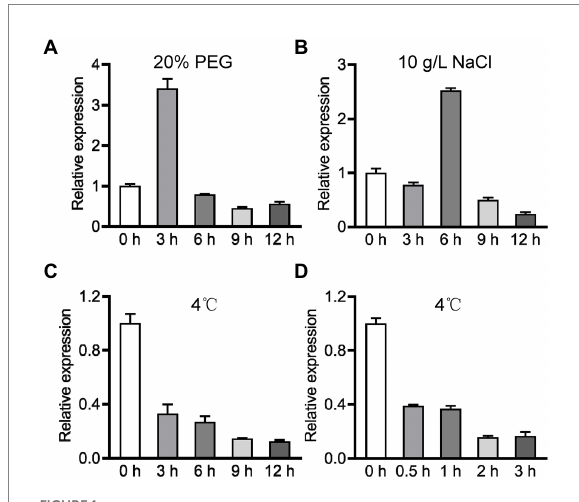
FIGURE 1 Expression profile analysis of OsPIN9 under various abiotic